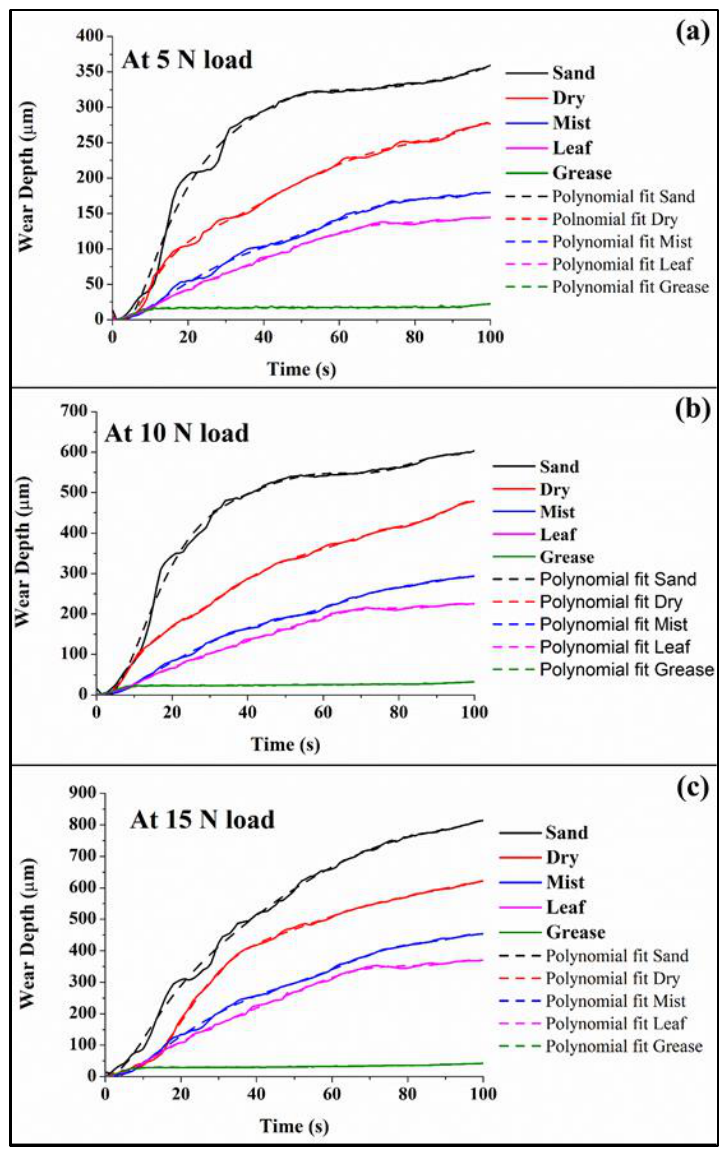
Figure 6. Variation of wear depth versus time for normal loads ( a ) 5 N ( b ) 10 N ( c ) 15